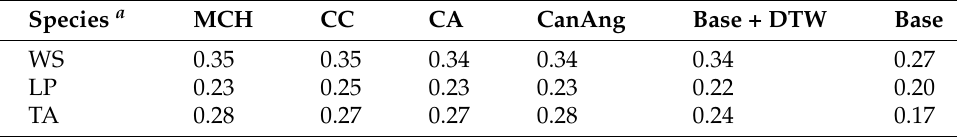
Table 4. Bayes-R 2 values for the six height growth models for each species.